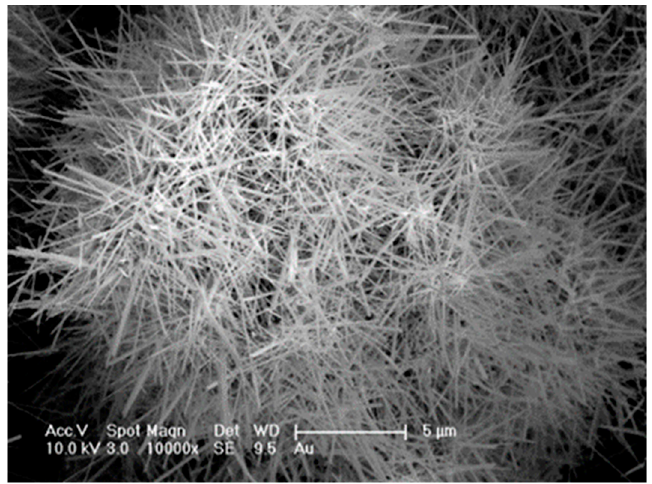
Figure 1. SEM view of an assortment of WS 2